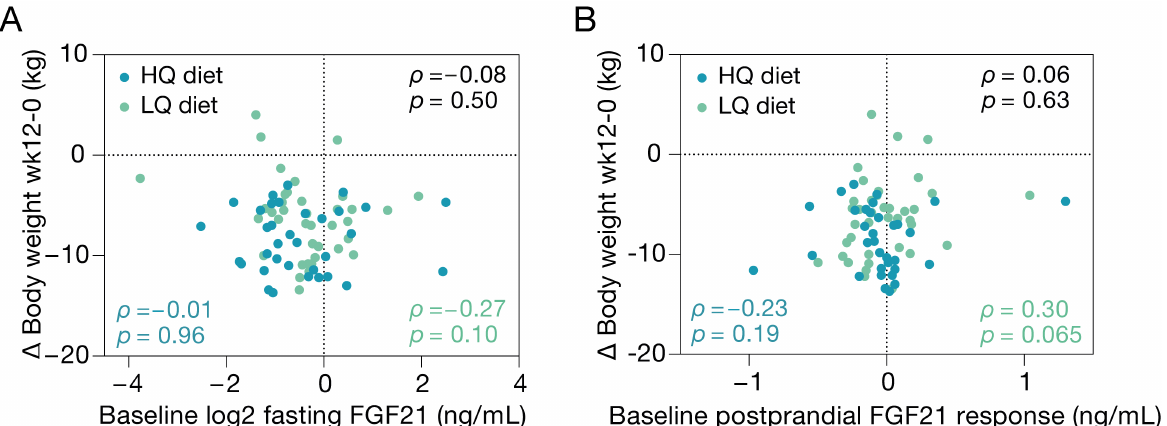
Figure 4. Scatter plots of fasting plasma FGF21 levels ( A ) and the postprandial FGF21 response ( B ) at baseline with weight change after 12 weeks of intervention on the high-nutrient-quality diet (HQ, dark green) and low-nutrient-quality diet (LQ, light green). Correlations were tested using Spearman correlation coefficients (LQ and HQ group combined in